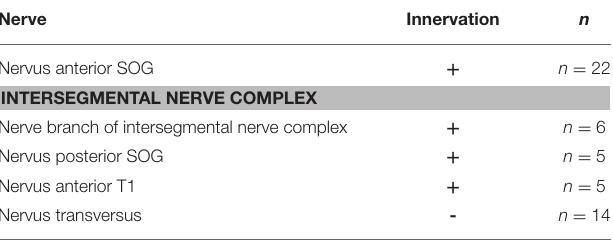
TABLE 1 | Innervation of the defense gland by distinct nerves in A. paromalus